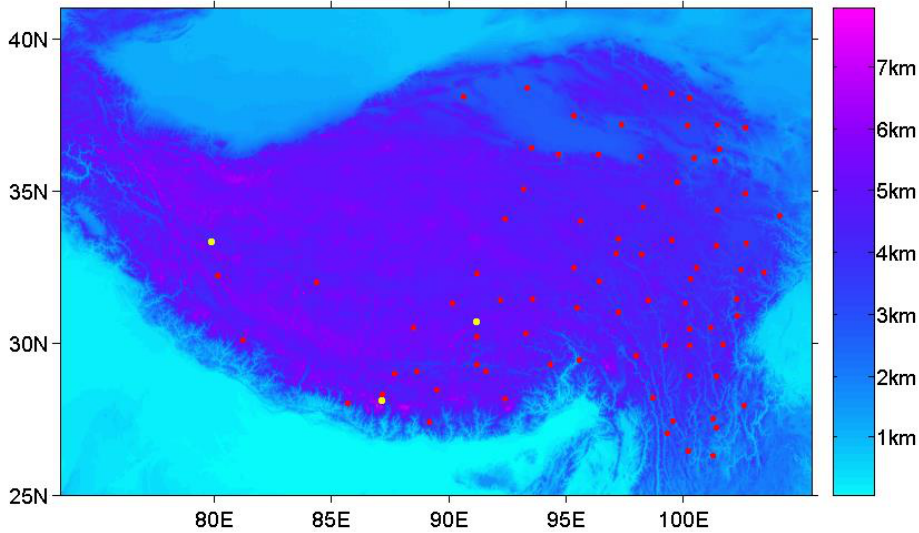
Figure 1. Locations of the three EC stations (yellow dots) and 80 CMA stations (red dots) on the TP. Table 1. Details of the three EC systems and observation periods.